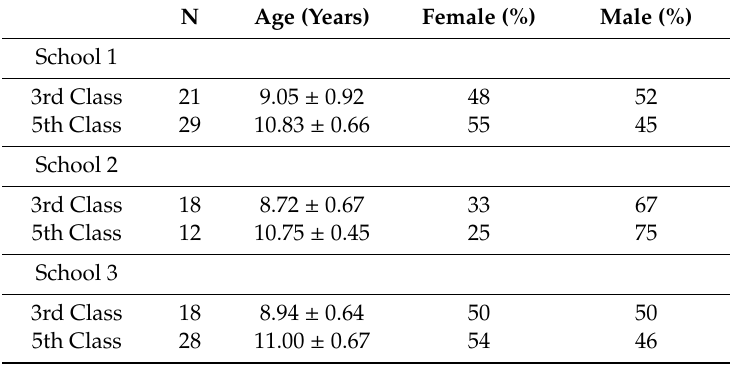
Table 3. Descriptive statistics for participants in each case study